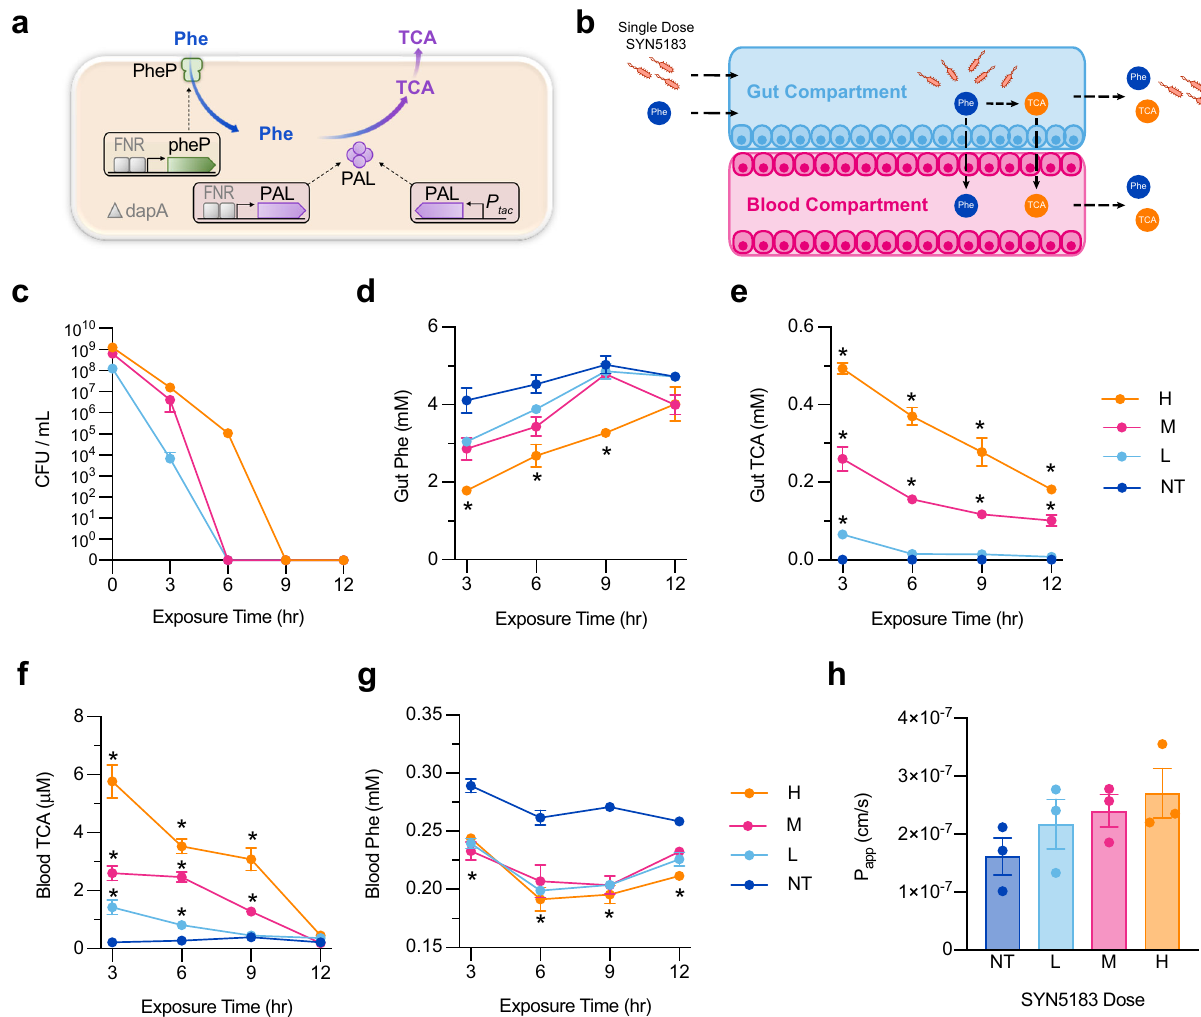
Fig. 2 Administration of single dose SYN5183 in a human gut-chip model. a Schematic representation of SYN5183 design. SYN5183 contains chromosomally inserted genes encoding PheP, a high-af fi nity Phe transporter that can bring Phe into the cytoplasm, and PAL, which converts Phe to TCA. Induction of these components is carried out partially by the anaerobic-responsive transcriptional activator FNR (fumarate and nitrate reductase regulator), for activation of PAL and PheP. An additional copy of PAL is placed under the control of an Isopropyl β -D-1-thiogalactopyranoside (IPTG) inducible promoter, P tac , for strain activation during production of drug product. Δ dapA indicates deletion of the dapA gene, leading to diaminopimelic acid auxotrophy. b Schematic of study design. SYN5183 was administered as a single bolus dose at the start of the experiment in the gut compartment, and SIF containing 5.0 mM Phe was continuously administered to the gut compartment. SYN5183 CFU were enumerated from gut compartment ef fl uents, and Phe and TCA were quanti fi ed using ef fl uents collected from the gut and blood compartments. c – e Concentrations of SYN5183 ( c ; CFU/mL, n = 3 chips), Phe ( d ; mM, n = 3 chips), and TCA ( e ; mM, n = 3 chips) recovered from gut compartment ef fl uents over time post-dose. f , g Concentrations of TCA ( f ; mM, n = 3 chips) and Phe ( g ; mM, n = 3 chips) recovered from blood compartment ef fl uents over time post-dose. h Apparent permeability ( P app ; cm/s) across the gut barrier 12 h post-dose. For ( c – h ), H, M, and L correspond to SYN5183 doses of 1.25 × 10 9 CFU/mL, 6.25 × 10 8 CFU/mL, and 1.25 × 10 8 CFU/mL, respectively. NT corresponds to non-treated chips. * p < 0.05, 2-way ANOVA, with a post-hoc Tukey analysis using a 95% con fi dence interval compared to the NT group, n = 6 independent gut chips, error bars represent SEM with the middle point representing the mean value. Source data are provided as a Source Data fi le. available small intestinal absorption surface area 4 . SYN5183 dose (LC-MS/MS). SYN5183 rapidly cleared the chips and was concentrations in the chips were selected to represent a range of undetectable in gut compartment ef fl uents 6 h after strain SYNB1618 doses used in healthy volunteers, considering administration for both the Low and Medium dose levels, and differences in scale (Clinicaltrials.gov Identi fi er: NCT03516487). after 9 h for the High dose level (Fig. 2c). Administration of 50 – 200 µL Phe-free medium was applied to cover the outlet ports SYN5183 resulted in a dose-dependent depletion of Phe in gut of the endothelial (blood) compartment and prevent bubble compartment ef fl uents (Fig. 2d). High dose SYN5183 signi fi cantly formation. This resulted in a modest dilution of measured Phe or reduced gut Phe levels at 3, 6, and 9 h compared to NT controls TCA levels at the 3-h time point (Fig. 2b). Gut and blood ( p < 0.05; 2-way ANOVA, with Tukey ’ s post-hoc analysis). Low compartment ef fl uents were sampled every 3 h to enumerate and Medium SYN5183 doses displayed a trend of decreased gut SYN5183, as well as to determine the concentrations of Phe and Phe concentrations that did not achieve statistical signi fi cance ( p = 0.067, in comparison to NT). SYN5183 treatment also elevated TCA by liquid chromatography with tandem mass spectrometry NATURE COMMUNICATIONS| (2021) 12:2805